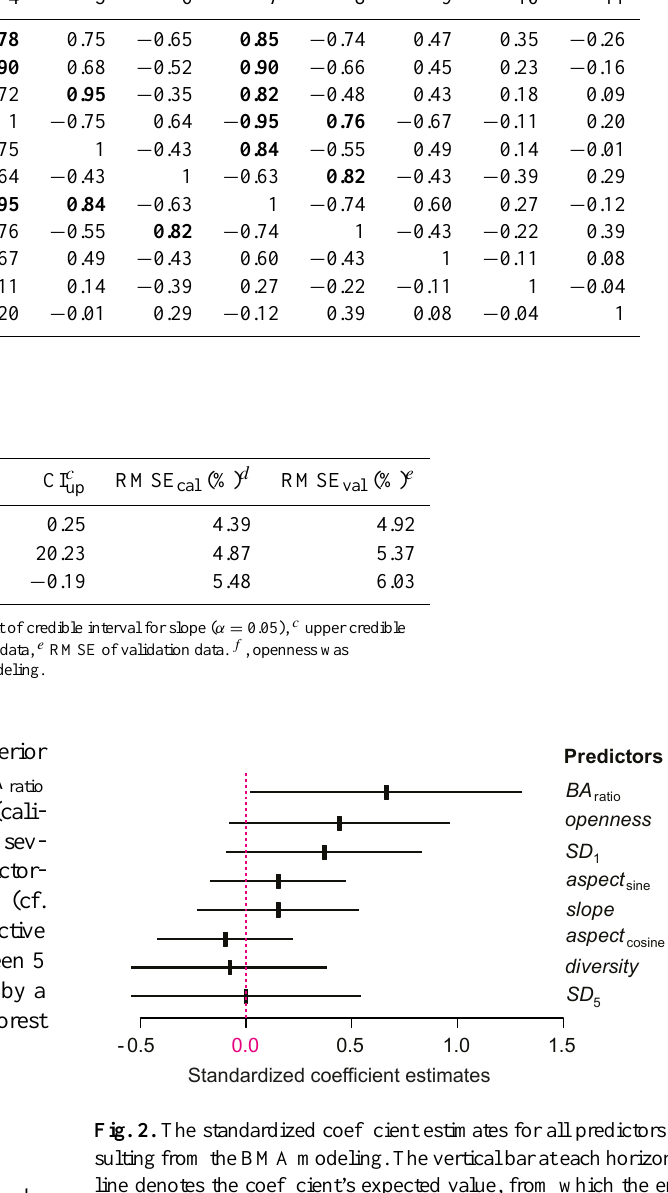
Table 2. Correlation matrix (Spearman’s rank correlation coefficients) for relative throughfall ( t r ) and forest structure parameters. Note: correlations < − 0.75 and >0.75 are shown in bold. Variable a